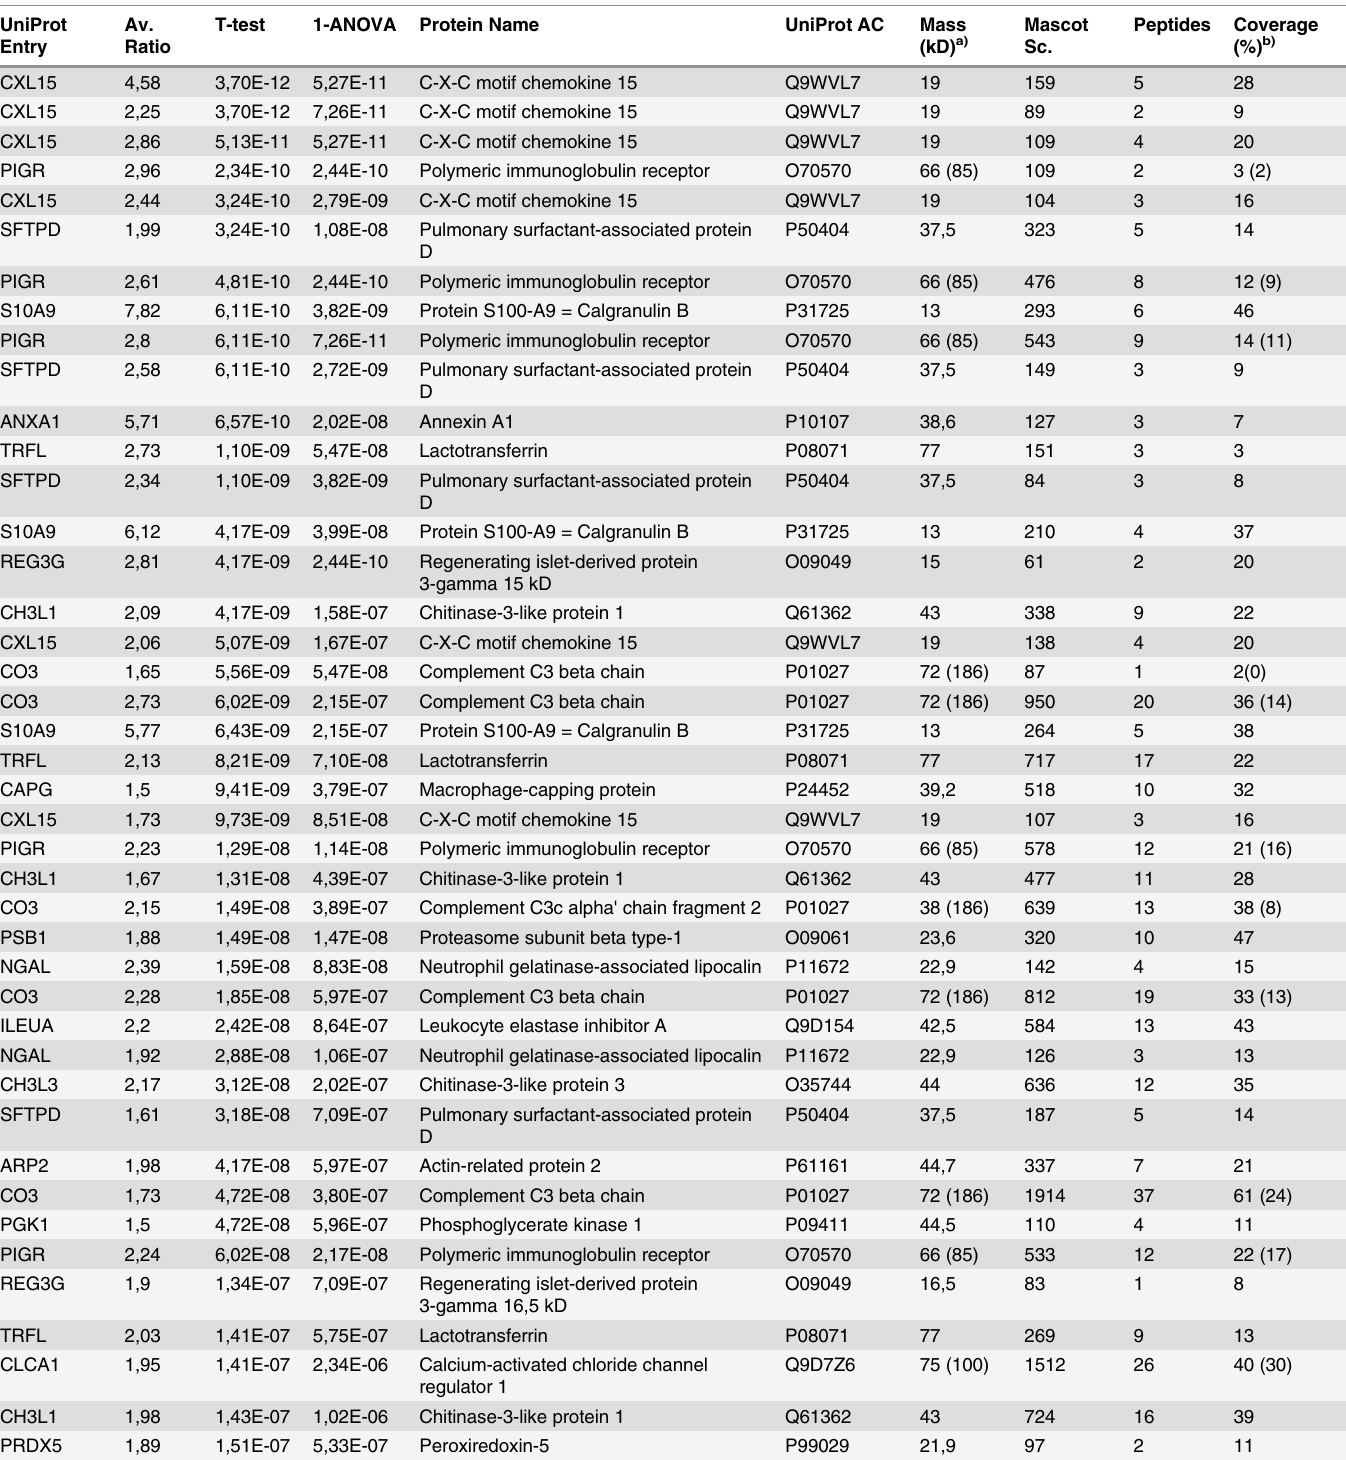
Increased abundance in a-GalCer-treated